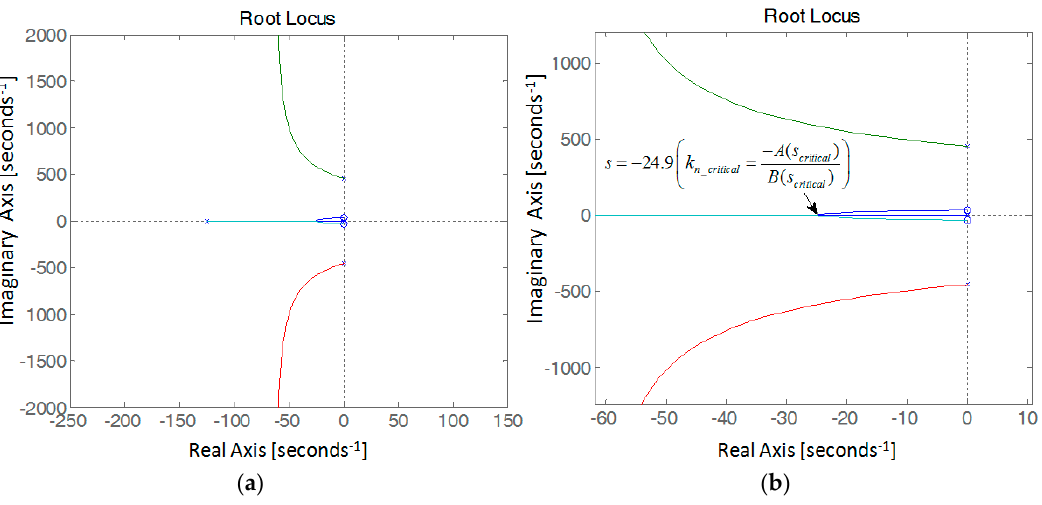
Figure 3. ( a ) Root locus of the power system transmission model; ( b ) Details of the root locus.